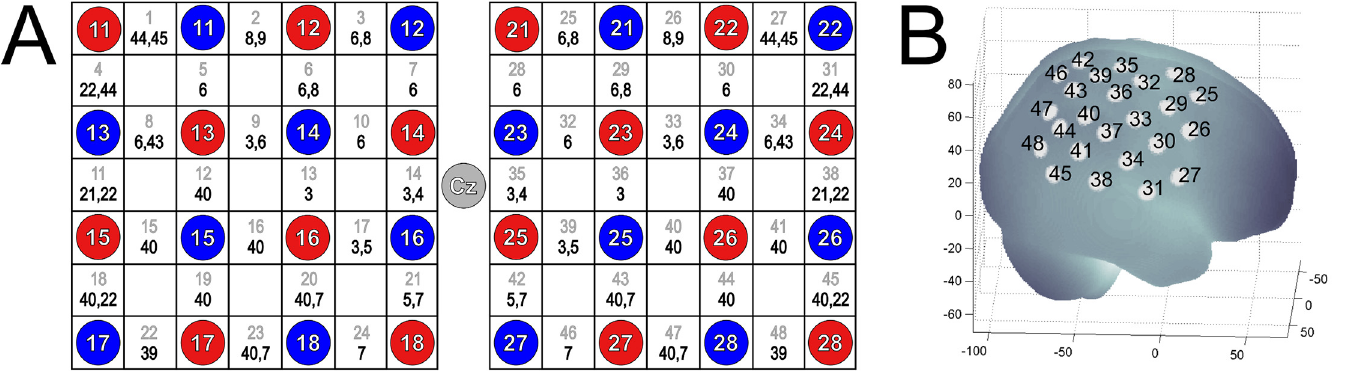
Fig 2. Position of the optode probe set on the head. (A) Channel configuration of the optode probe set (2x4x4). The gray numbers in the white rectangles represent the NIRS channel number and the corresponding Brodmann areas are shown in black. The NIRS probe set of 48 channels was positioned over right and left motor cortex. Red and blue circles illustrate positions of NIRS sensors and detectors, respectively. According to the international 10 – 20 placement system we used Cz, T7 and T8 as marker positions for ensuring replicable placements of the optodes. (B) Projections of the 48 NIRS channel positions (white points) on the cortical surface over the right hemisphere. NIRS positions are overlaid on a MNI-152 compatible canonical brain that is optimized for NIRS analysis according to a procedure of Singh et al. (2005)